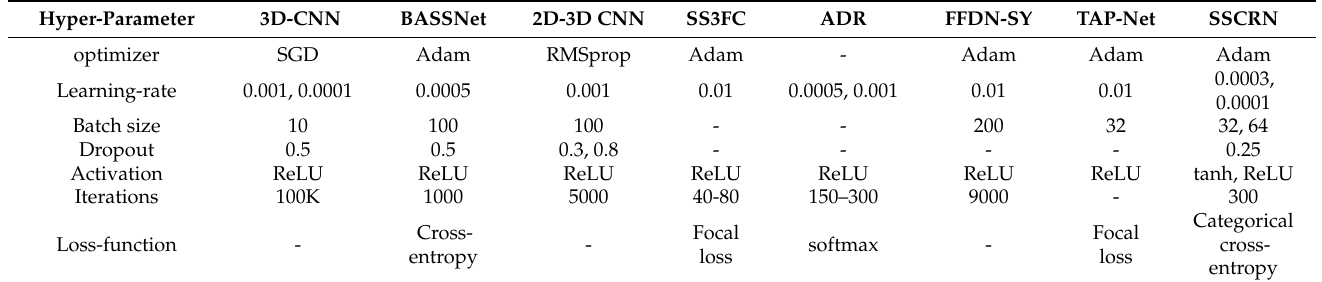
Table 6. Comparison of hyperparameters with state-of-the-art